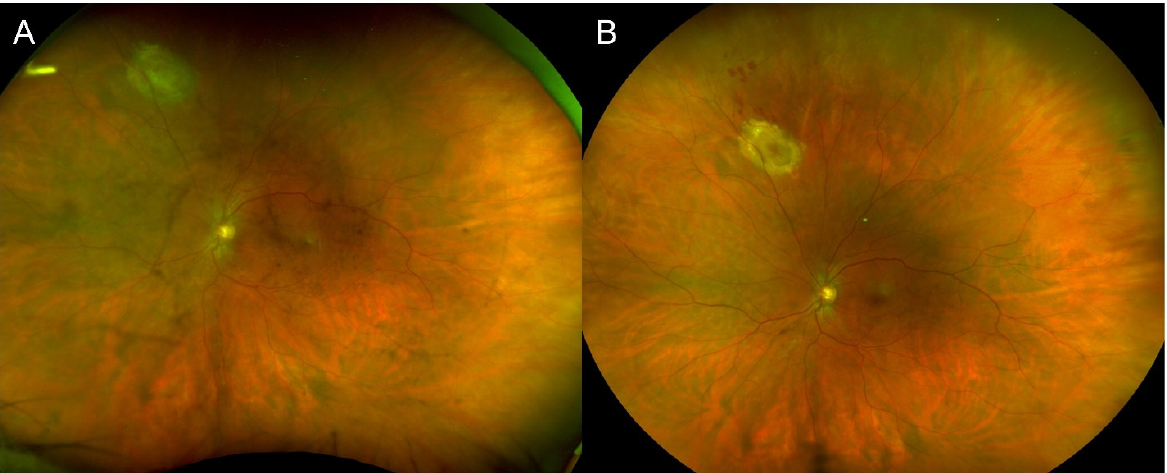
Figure 2. Case 2 with active toxoplasmosis retinochoroiditis 3 months after a first dose of COVID- 19 vaccination. ( A ) Fundus photography showing the initial elevated, yellow whitish lesion with surrounding pigmentary changes. ( B ) Six weeks later, the main lesion became cicatricial.